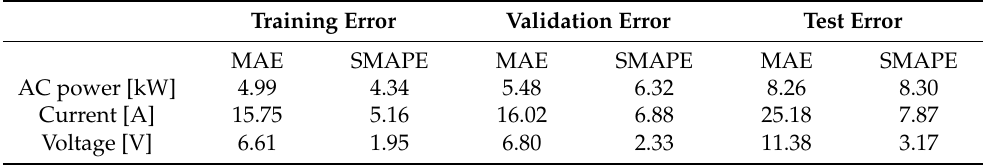
Table 1. Power generation estimation performance of the estimation model based on DNNs.